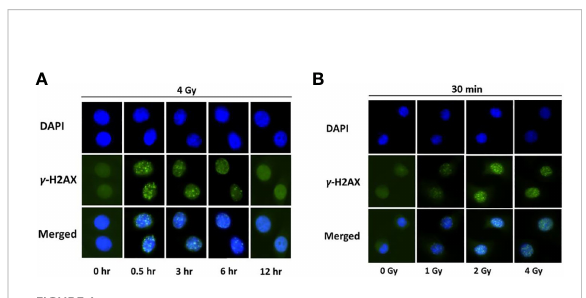
FIGURE 1 H2AX is phosphorylated in normal oral keratinocytes exposed to proton radiation. (A) Immuno fl uorescence of g -H2AX at different time-points (0, 0.5, 3, 6, 12 hr) in normal oral keratinocytes irradiated with 4 Gy of protons. Nuclear DNA was counterstained with DAPI. (B) Immuno fl uorescence of g -H2AX in NOK cells, 30 minutes after exposure to different doses of proton radiation (0, 1, 2, 4 Gy). Nuclear DNA was counterstained with DAPI. Images are representative of three independent experiments.